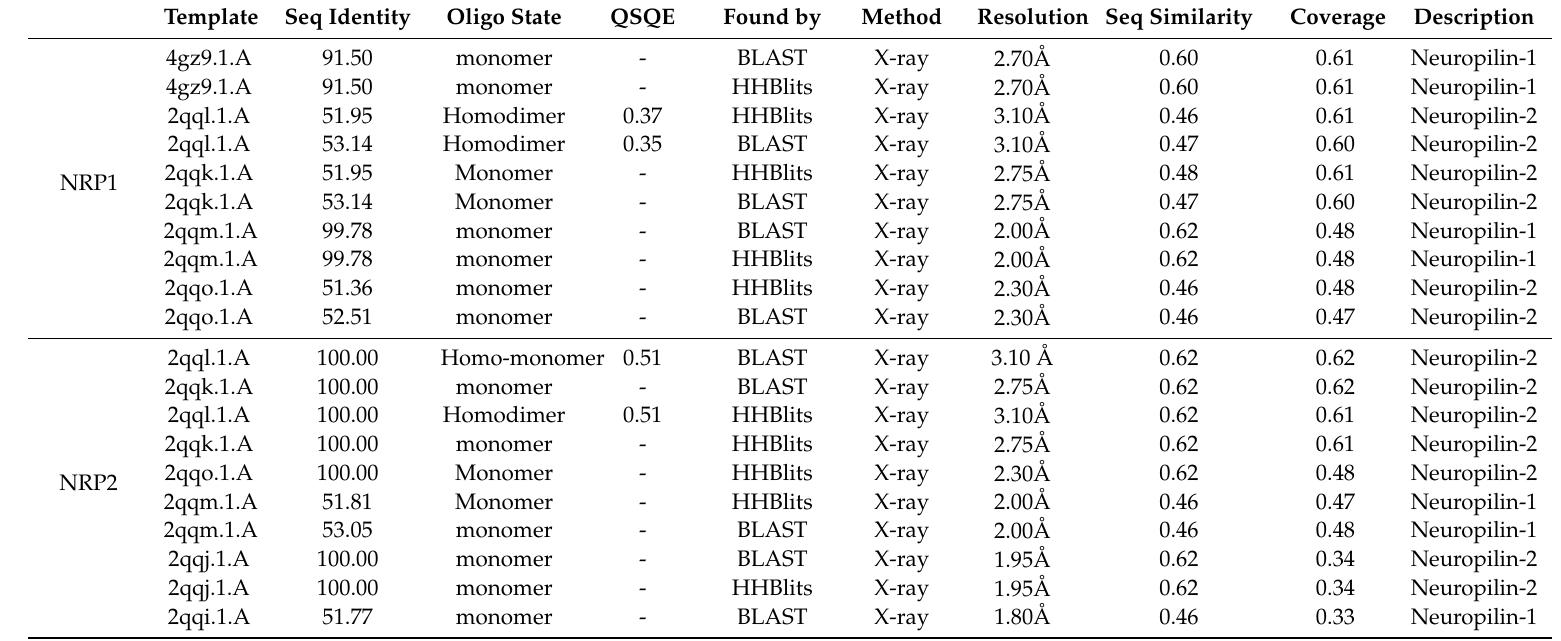
Table 4. Best models for 3D modeling of the NRP1 and NRP2 structures. Abbreviation: QSQE = quaternary structure quality